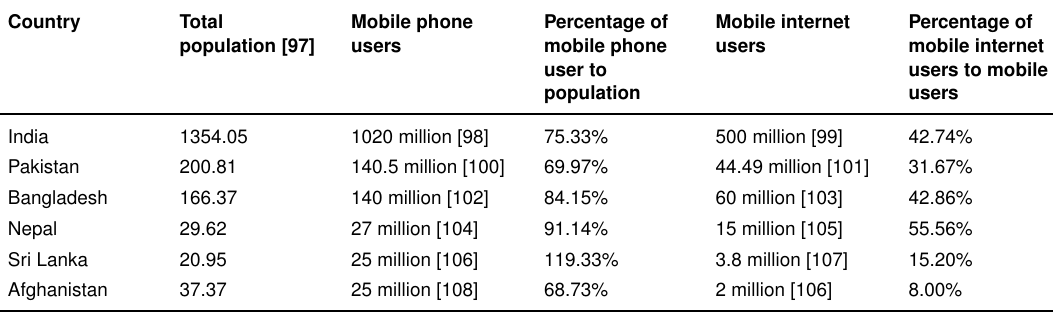
Table 4. Mobile phone penetration in selected South Asian